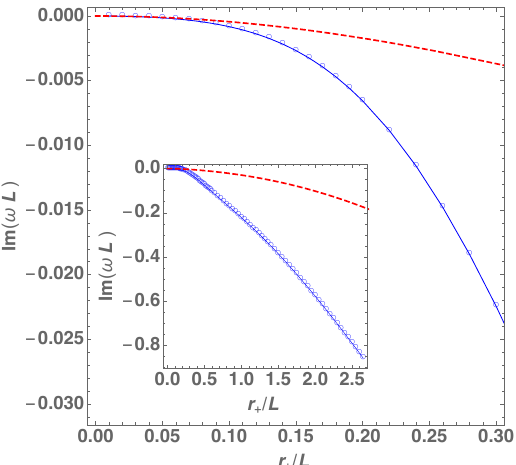
Figure 11 . Imaginary part of the frequency as a function of the horizon radius for (cid:12)xed chemical potential (cid:22) = (cid:22) ext ( m = 0 ; ‘ = 1 = 2 and alternative quantization). The red dashed line is the 2 analytical approximation (C.1). The inset plot zooms-out the main plot.